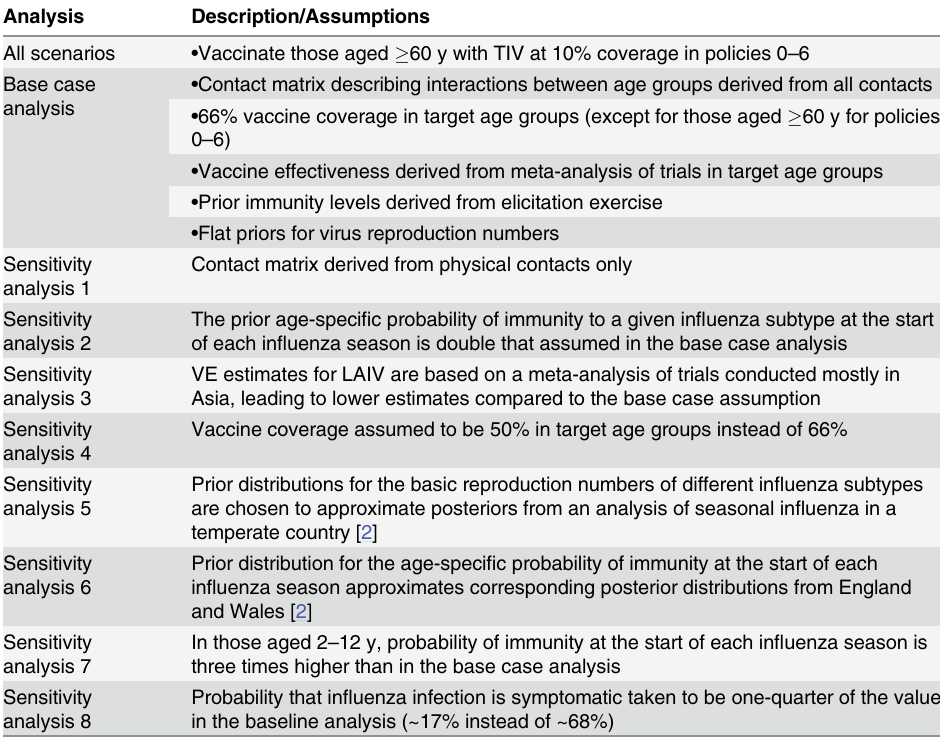
Table 2. Analyses and